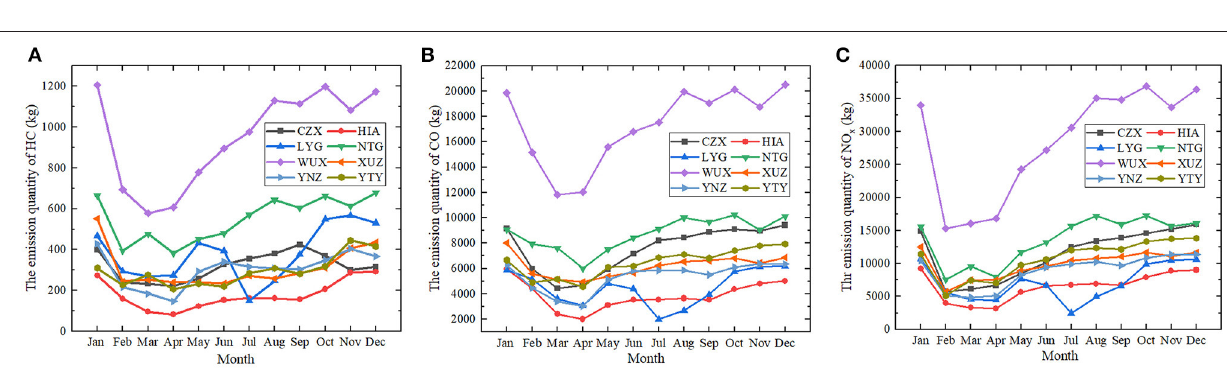
FIGURE 4 | The monthly variation of the air pollutants at 8 airports in Jiangsu province (except for NKG), 2020. (A) The emission quantity of HC in kilograms (B) The emission quantity of CO in kilograms (C) The emission quantity of NO x in kilograms. CZX, Changzhou Benniu Airport; HIA, Huaian Lianshui Airport; LYG, Lianyungang